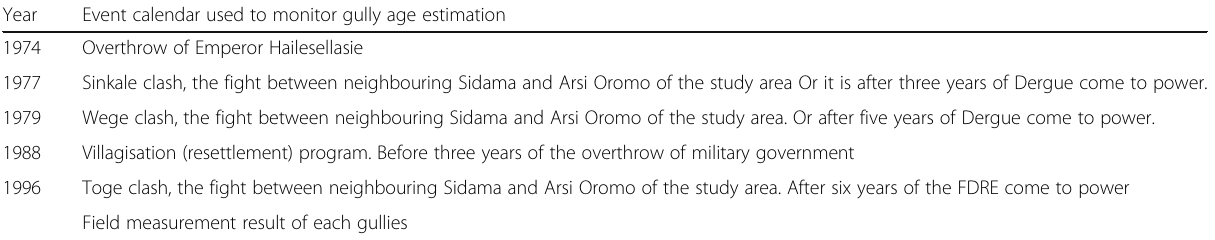
Table 1 Event calendar used to monitor gully age